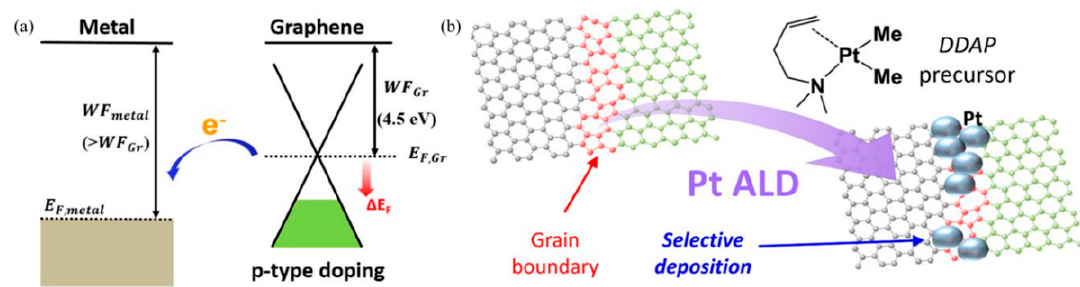
Figure 10. Concept of metal atomic layer deposition (ALD) on graphene. ( a ) Doping graphene by charge transfer between graphene and metal. ( b ) Selective deposition of Pt by ALD on graphene